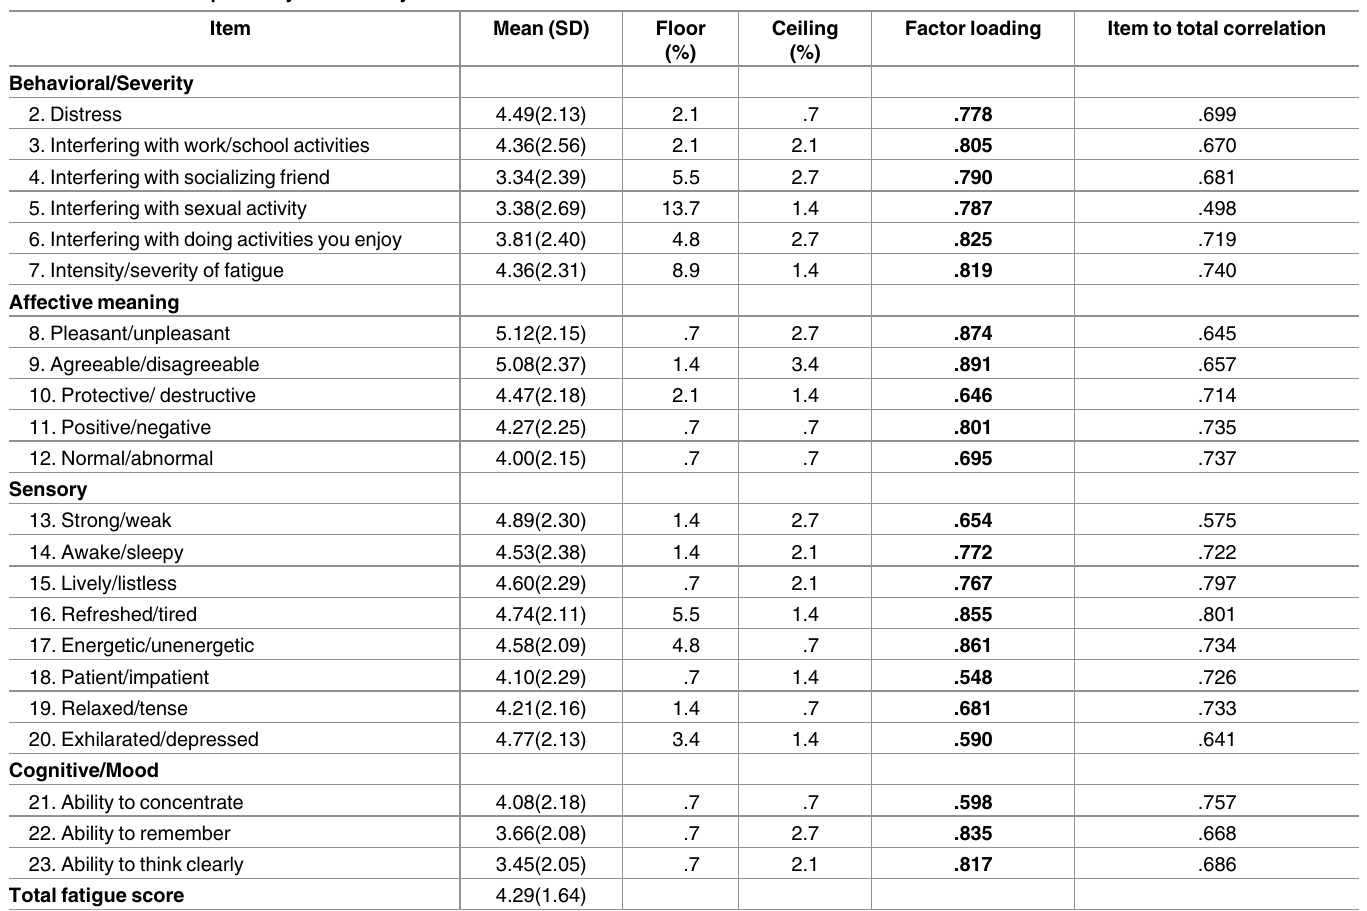
Table 4. Results of exploratory factor analysis.